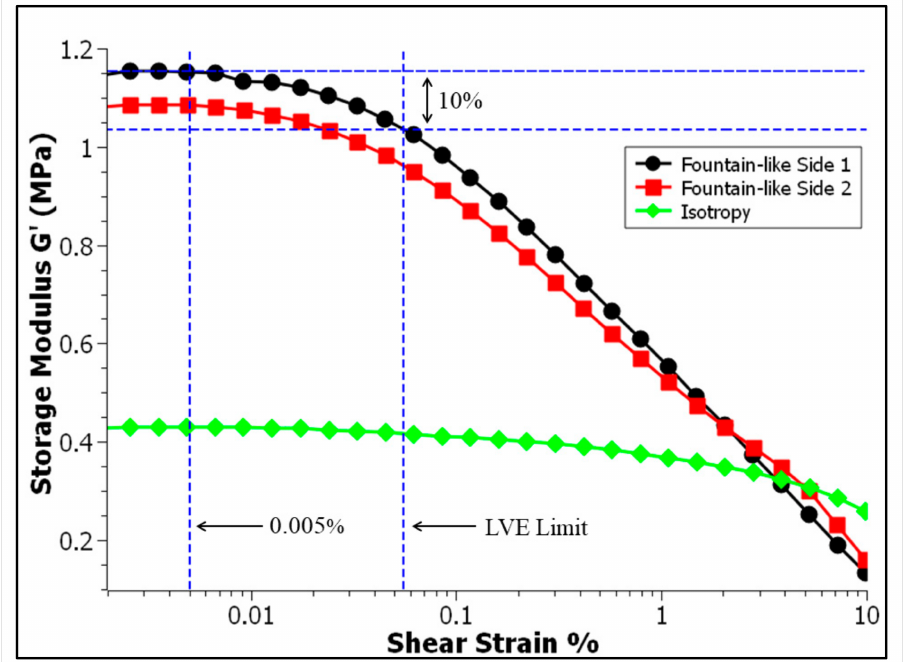
Figure 7. Determination of the LVE region of the